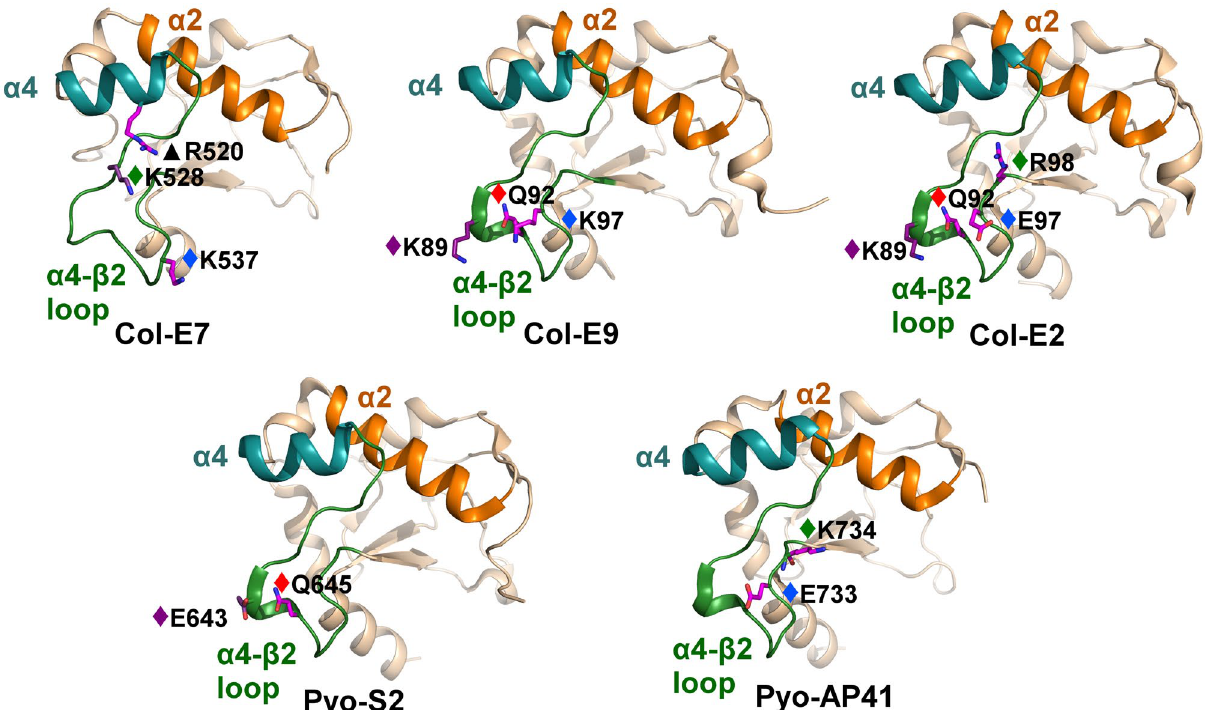
Figure 6. Limited electrostatic contributions of colicin/pyocin residues to interactions with the α2 helix and adjacent residues in immunity proteins. Colicin residues that substantially contribute electrostatically to interactions with the Im α2 helix are shown as sticks and colored according to their energy contributions, as in Fig. 5. Colicin residues that contribute similarly to interactions across multiple members are marked with diamonds and colored as follows (the corresponding E7 position number, as in Fig. 3B, is also noted): purple (E7#531), red (E7#534), light blue (E7#539), and green (E7#528 or E7#540). Colicin residues that contribute to interactions with the cognate immunity protein only in one complex are marked with black triangles. The colicin/pyocin α2 helices are colored orange, the α4 helices are colored teal, and the α4–β2 loops are colored green. Colicin/pyocin structures are rotated 35° about the Y-axis relative to Fig.